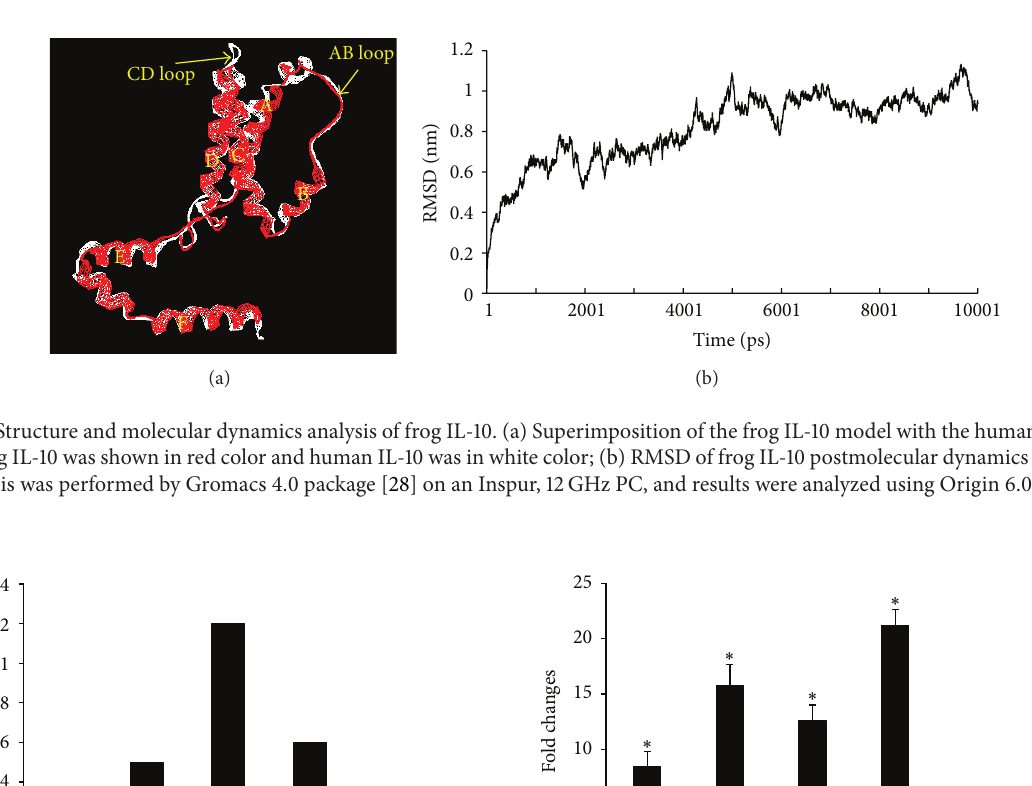
cluster was further divided into three main clades: fish